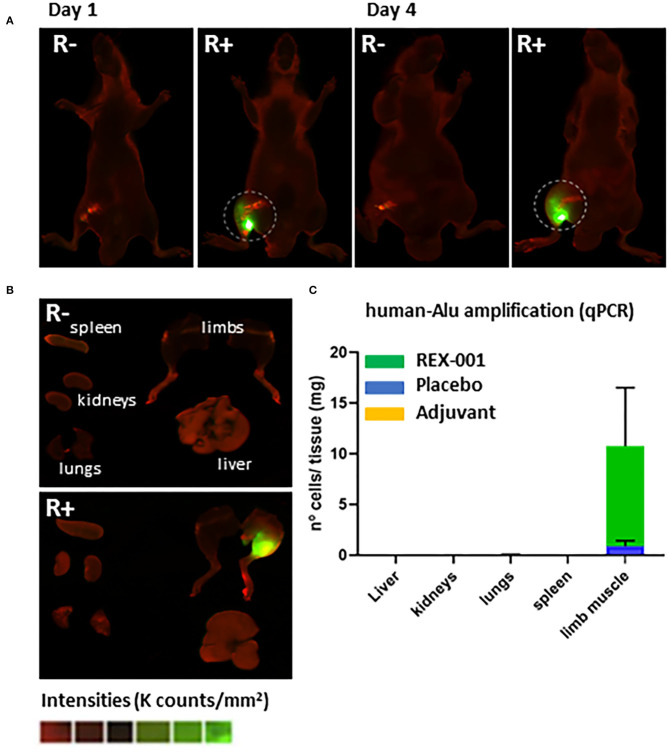
Biodistribution assay. (A) Representative images of NiR scanning performed in vivo on day 1 (after cell administration) and day 4 in Balb-c nude mice with DiR pre-labeled REX-001 (R+, n:3) or with un-labeled cells (R-), both administered intramuscularly. (B) Representative images of ex vivo NiR scanning for the organs extracted on day 4 for the R+ and R- mice (lungs, spleen, kidneys, liver, and limbs). Intensity values were calculated as K counts/mm2, with final R+ intensities calculated after subtracting background, negative signal from R- mice. (C) The number of cells detected per mg of organ tissue analyzed on day 4 (after cell administration) in Balb-c nude treated with either REX-001 cells (R, n:3), placebos (P, n:3) or adjuvants (A, n:3) was calculated after measuring the presence of human DNA with specific Alu sequences and qPCR analysis, in several organs (spleen, kidneys, lungs, liver, left limb).